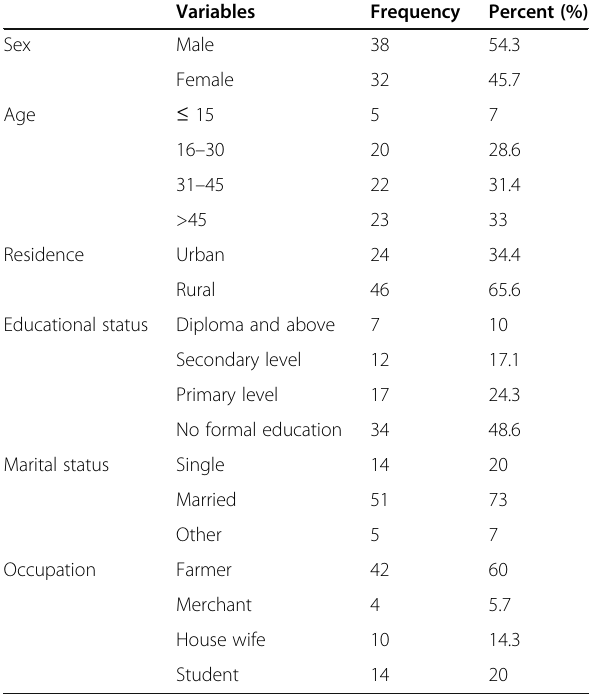
Table 1 Socio-demographic characteristics of study participants ’ attending Adet Primary Hospital from February 1 to March